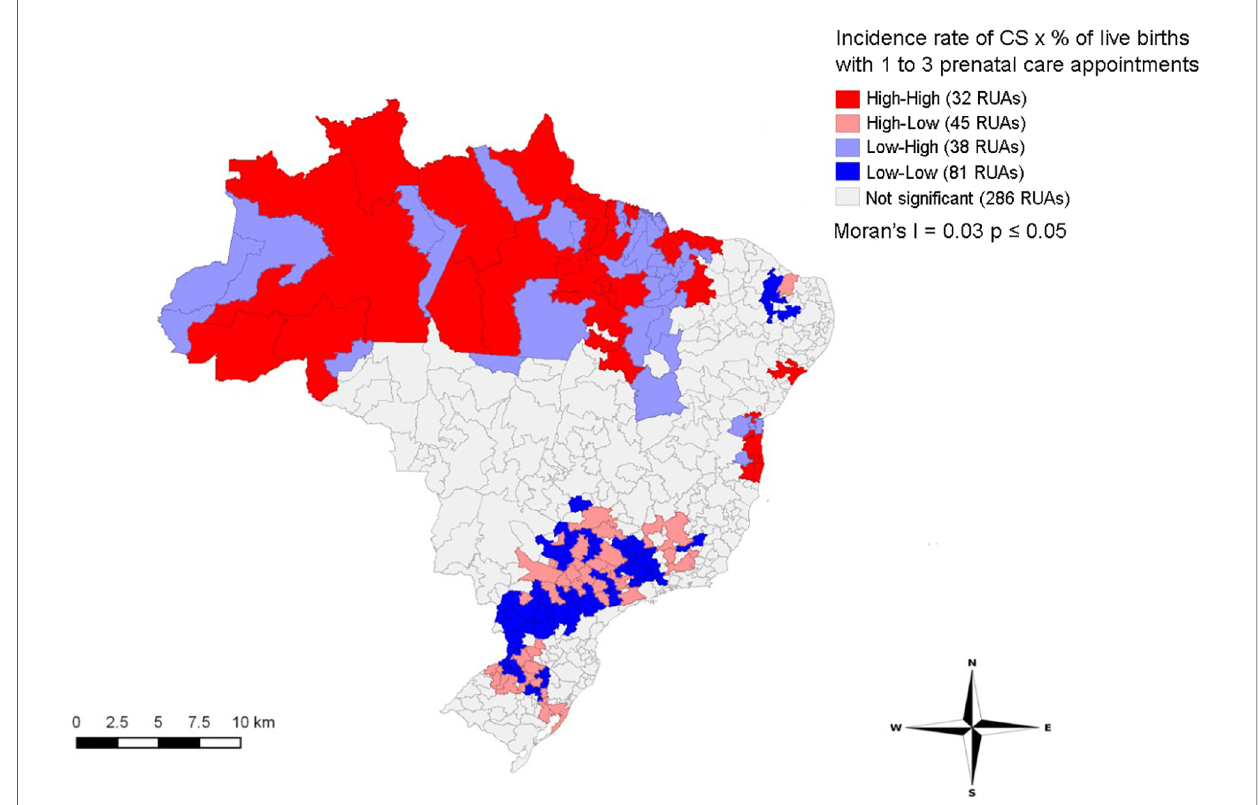
FIGURE 5 Distribution of LISA bivariate spatial correlation clusters of congenital syphilis incidence rate with the indicator prenatal care in immediate regions of urban articulation in Brazil, 2008 –